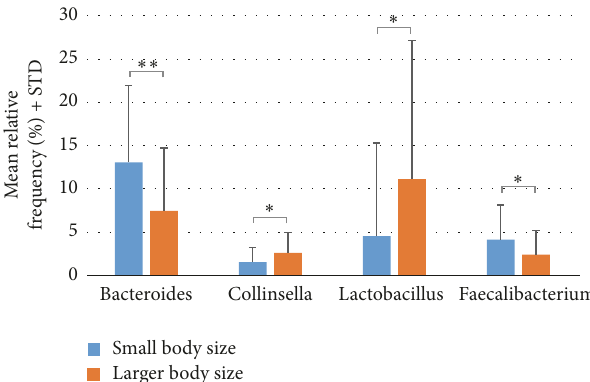
Figure 1: Fecal microbiota differences (genus level) between small dogs and dogs of larger body size. Microbiota differences with 𝑃 value < 0.05 and relative frequencies greater than 1% are shown. ∗∗ 𝑃 < 0.01; ∗ 𝑃 < 0.05.